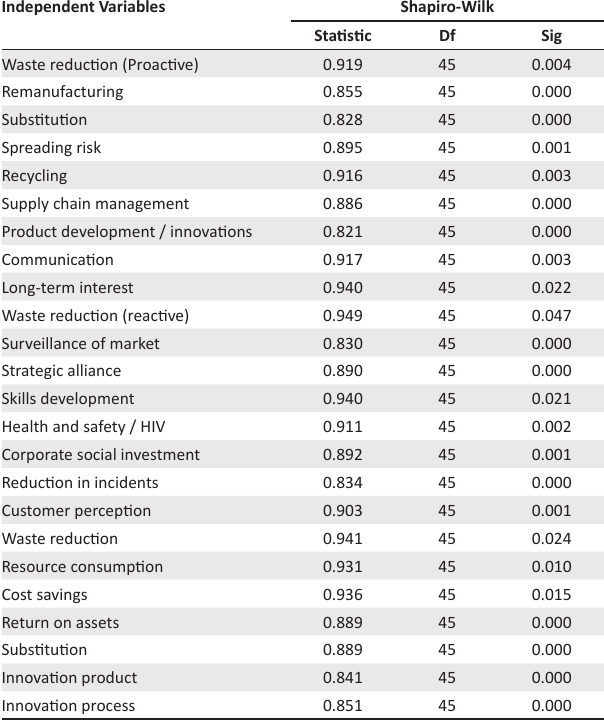
TABLE 5: Test of normality on significant independent and dependent